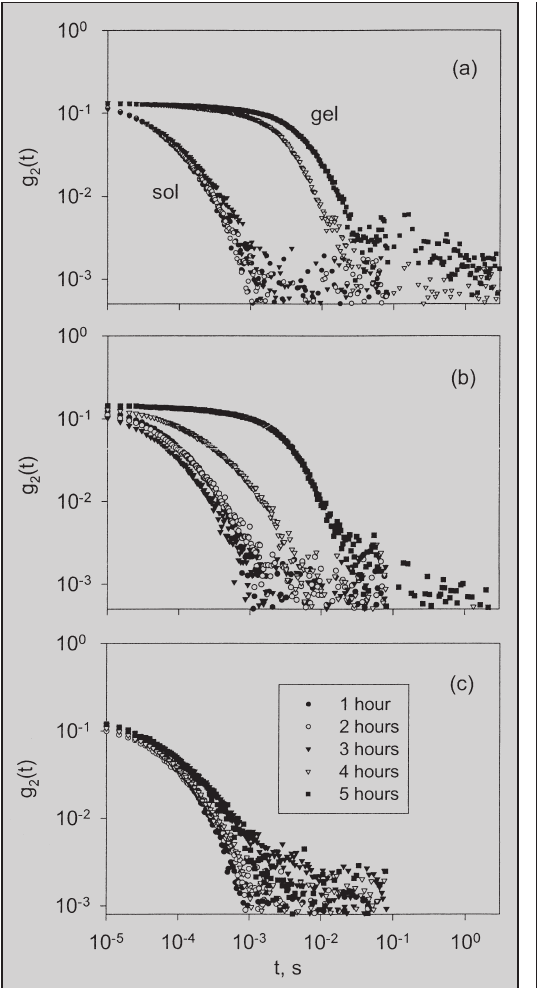
Figure 1: The evolution of the temporal intensity correlation function in the samples of AMG prepared with different amounts of GDL: (a) 2%, (b) 1.8%, and (c) 1.4%, during the acidification/ gelation